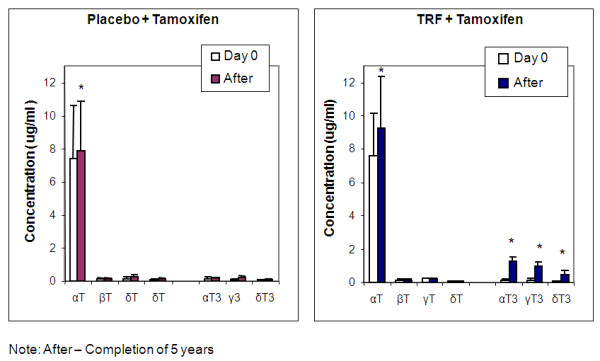
The α-tocopherol, α-, γ-, and δ-tocotrienol concentrations increased significantly after 5 years for the TRF-supplemented group. *P < 0.05.